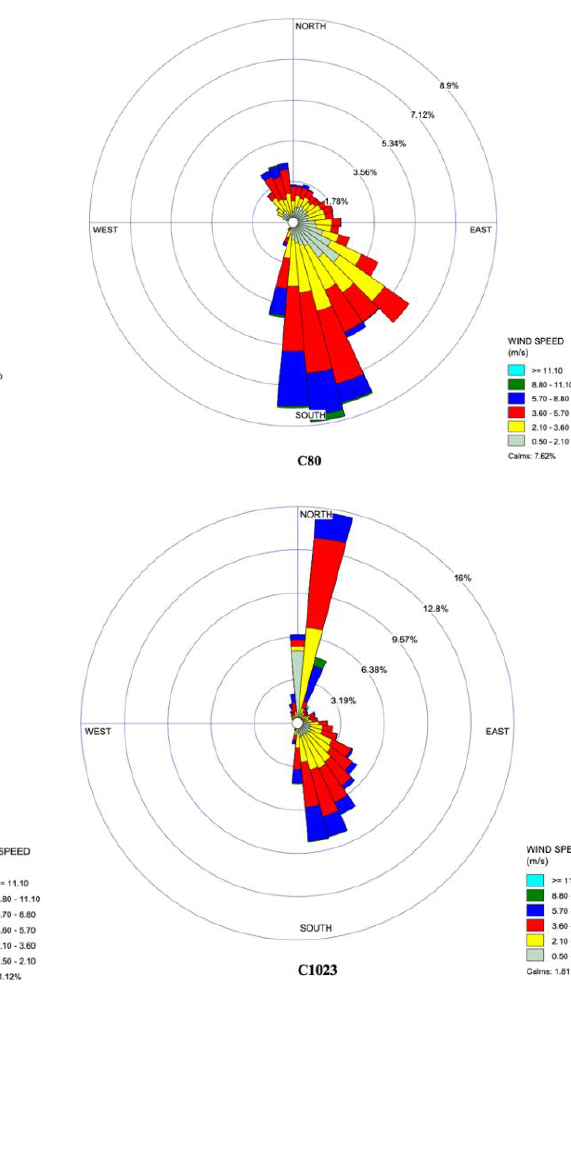
StDev = standard deviation, RWS = resultant wind speed in m/s, T = temperature in (°C), SR = solar radiation measured in Langley’s per minute.